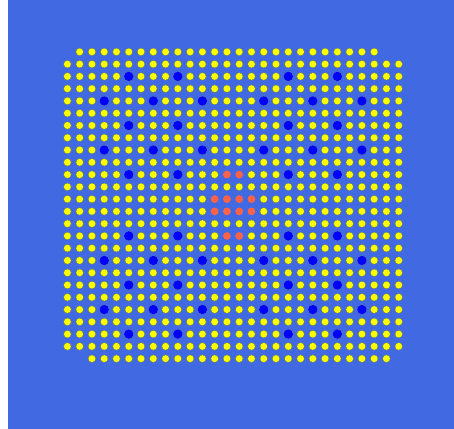
Figure 1: LEU-COMP-THERM-044 Case